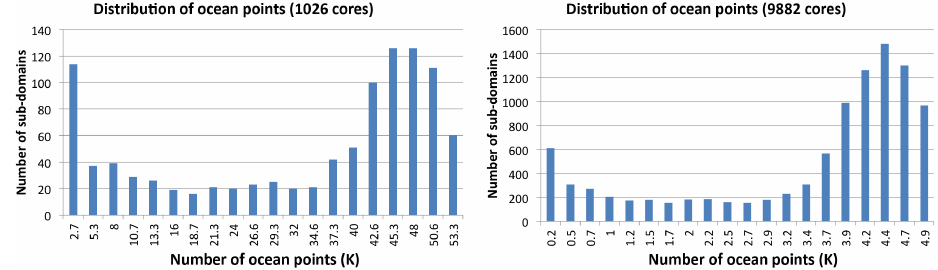
Figure 11. Histogram of the ocean point distribution using the one-dimensional data structure for two different configurations, with 1026 and 9882